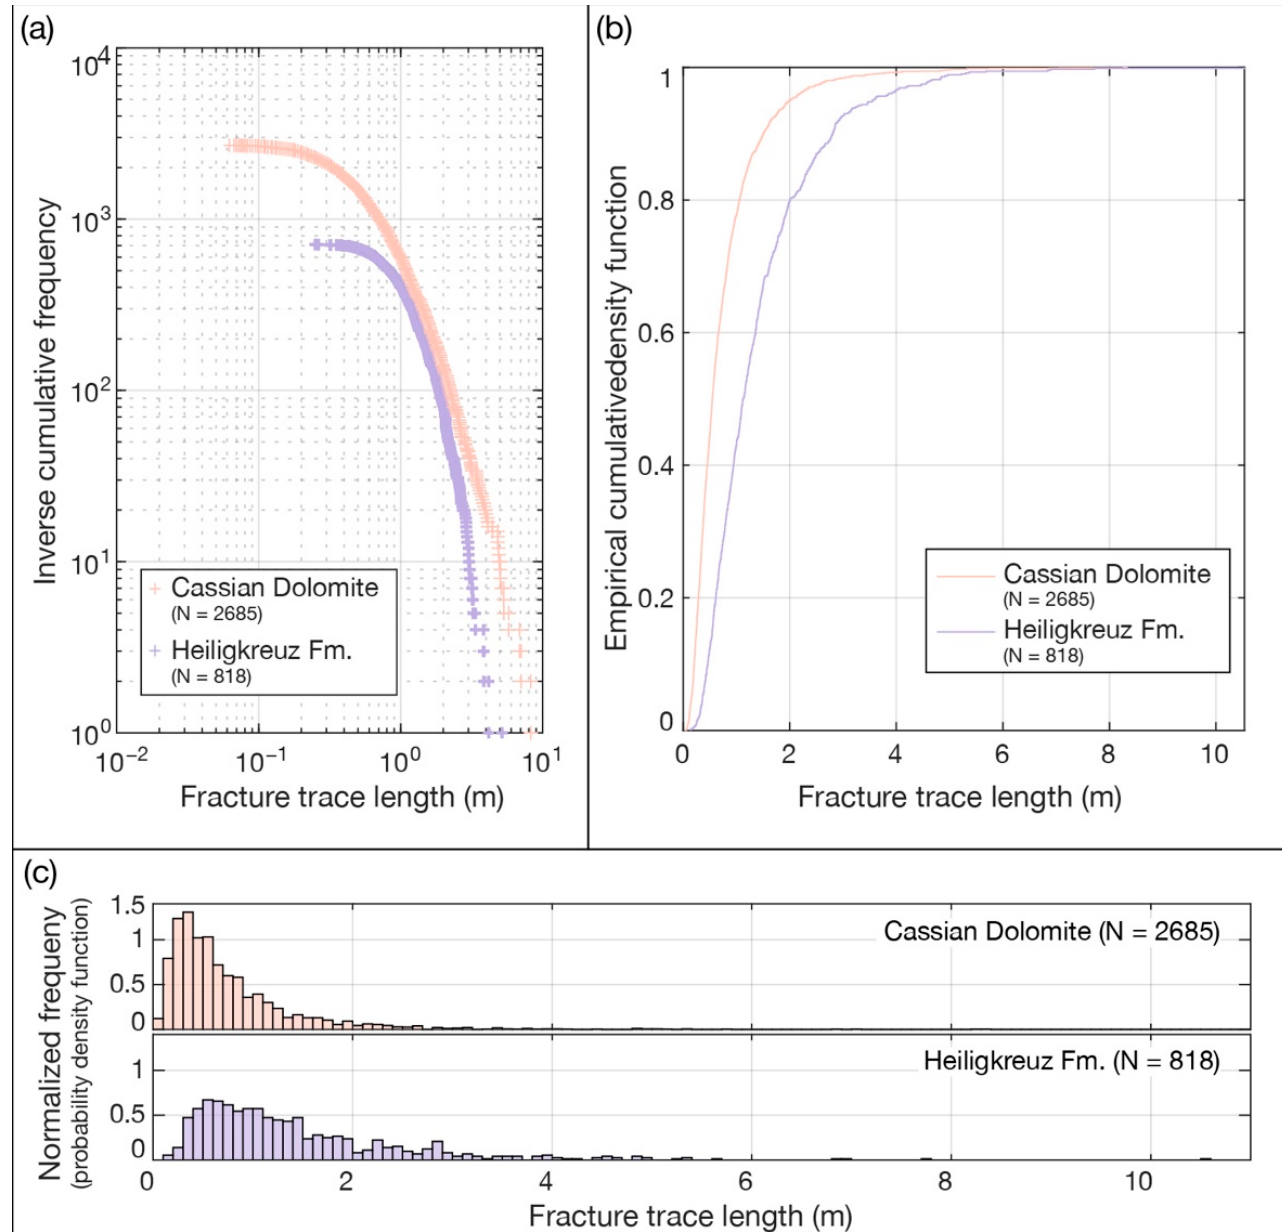
Figure 9. ( a ) Inverse cumulative frequencies, ( b ) empirical cumulative density function, and ( c ) normalized histograms (bin size 10 cm and normalized by probability density function) of the length of fracture traces mapped onto the digital scan areas analyzed onto the Cassian Dolomite and Heiligkreuz Fm.